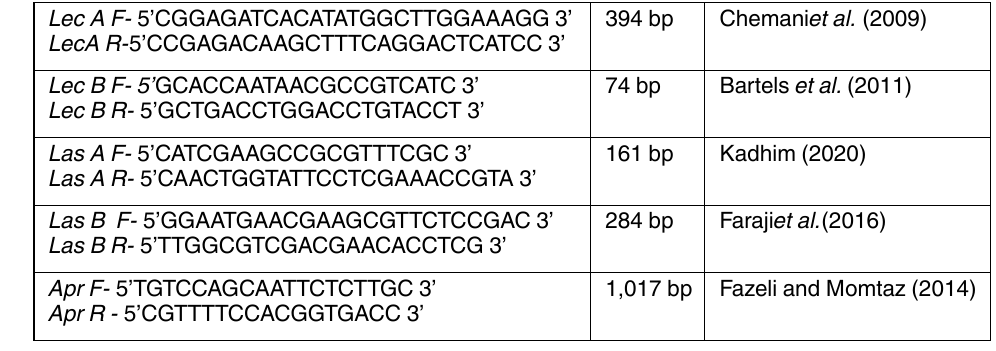
Table 1. Primers of virulence genes of Pseudomonas